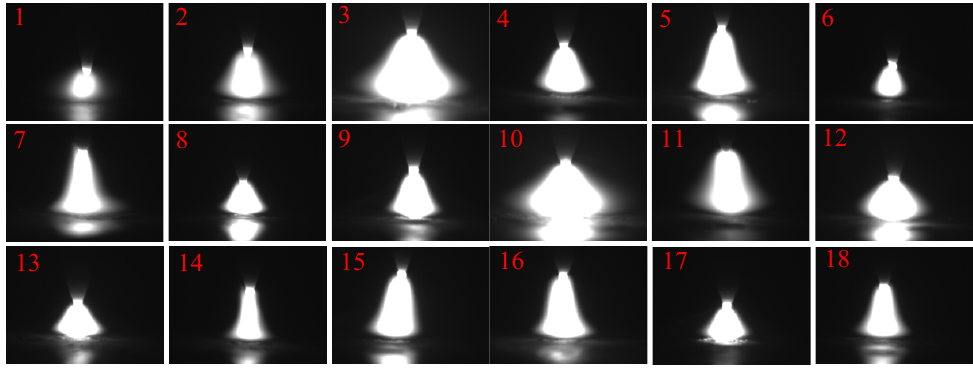
Figure 5. The arc images. (Note: the numbers 1,2,3,…..18 is expressed the images of arc shape in Table 1).